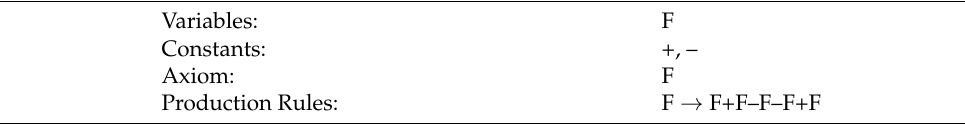
Table 3. Construction rules to produce a Koch curve using L-systems. Starting with the axiom “F”, at each iteration, “F” is replaced by “F+F–F–F+F”. As constants “+” and “–” are not replaced in successive iterations. Including an interpretation layer, we can sketch the Koch curve created. “F” represents a line, “+” represents a right turn in the lines’ direction, and “–” represents a left turn in the lines’ direction.